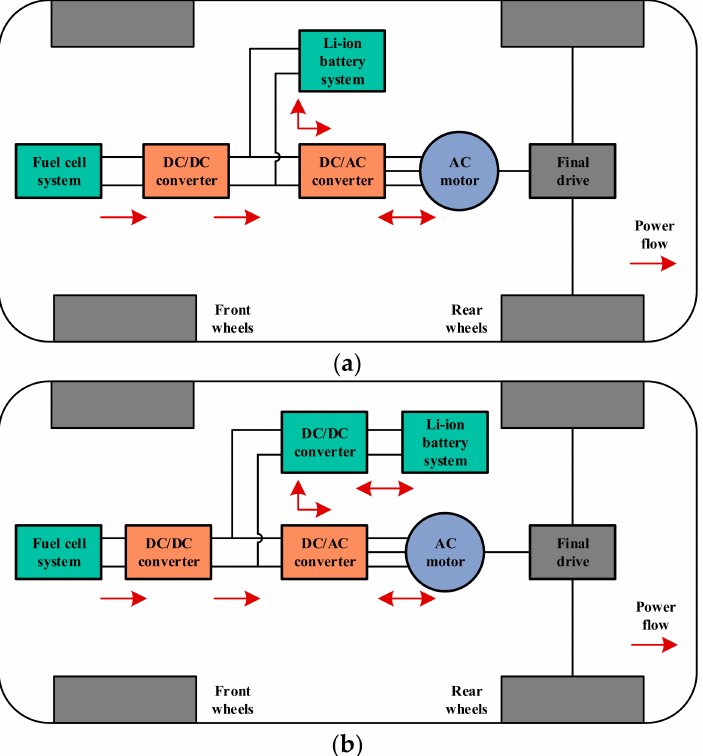
Figure 3. Topologies of FC + battery: ( a ) batteries disconnected to the DC/DC converter; ( b ) batteries connected to the DC/DC converter.